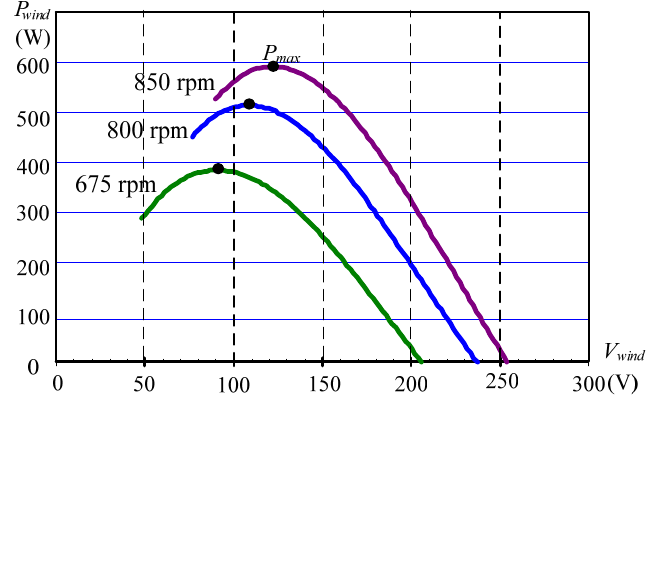
Figure 11. Typical output power characteristic curves of the wind turbine under different driving power from the dc